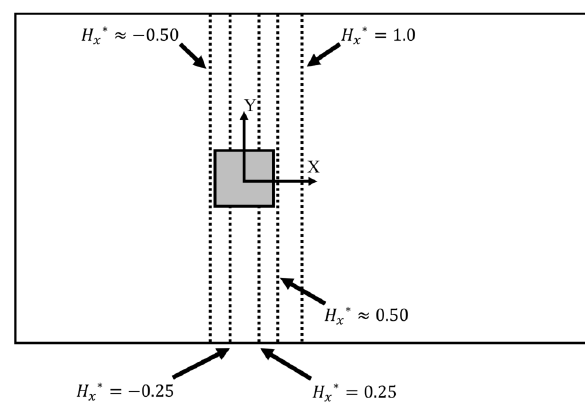
Figure 11. Locations of the probe rakes reported. Note that dimensions are not to